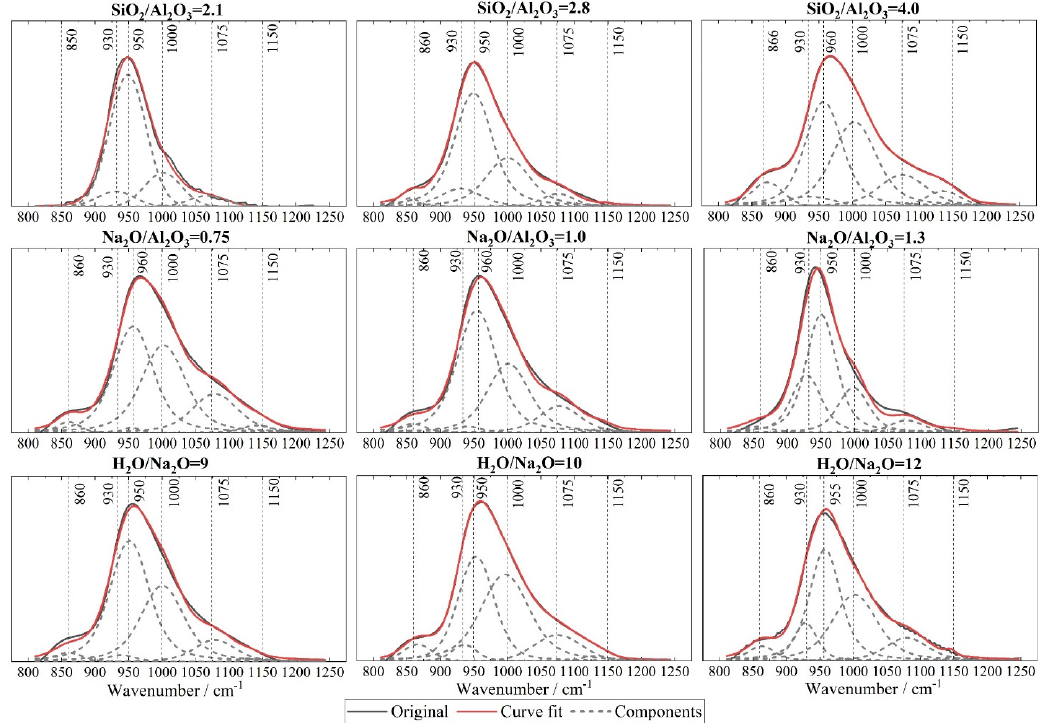
Figure 7. FTIR spectral deconvolutions of the main Si-O-T stretching band positioned at 800~1250 cm − 1 for geopolymers reported in Figure 6.